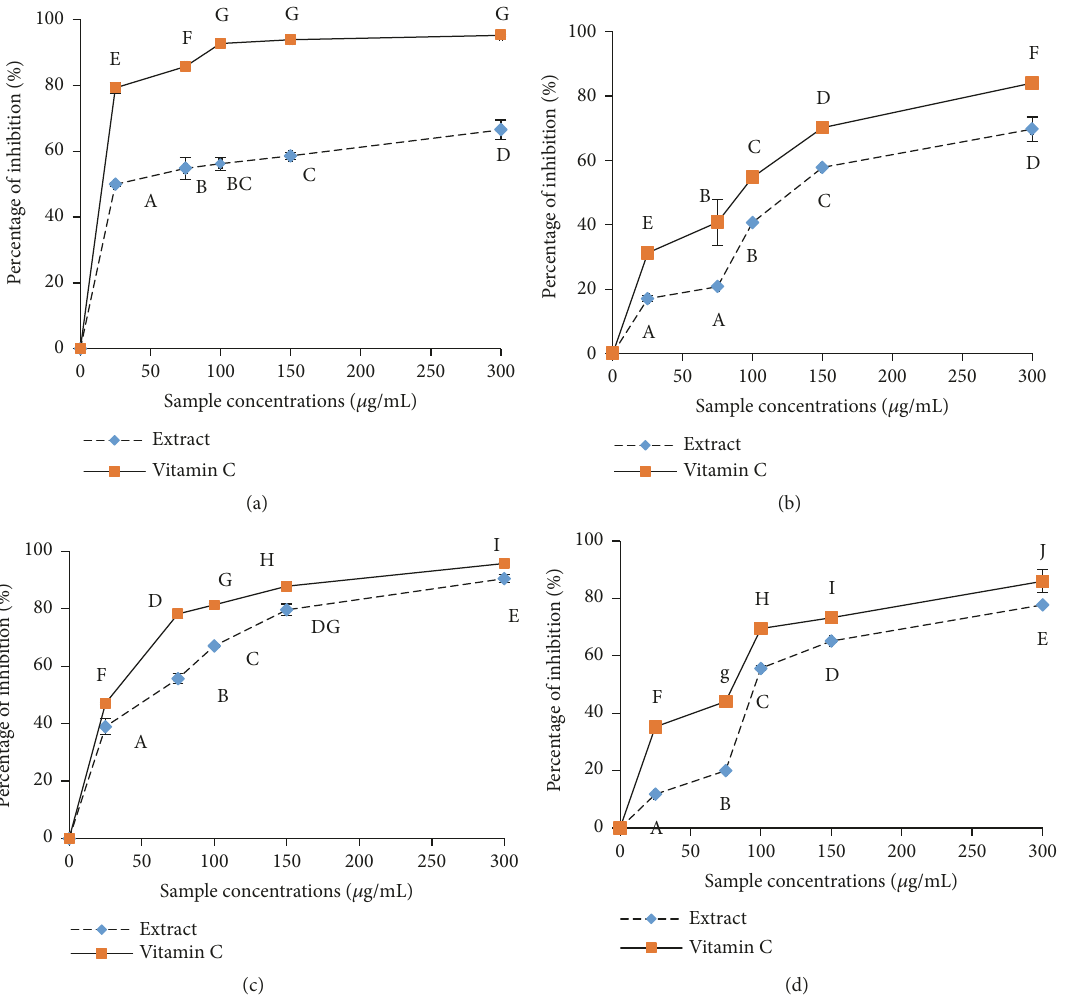
index was 29.38 ± 1.02 (10-4) for SOD, 15.09 ± 1.24